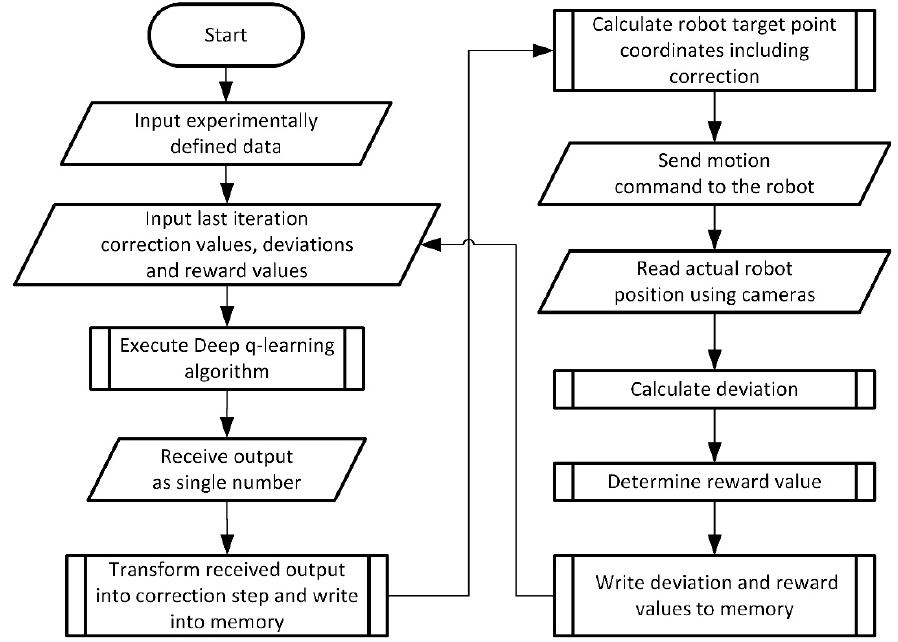
Figure 15. Flowchart of machine learning based positioning errors compensation procedure. The compensation parameters were applied by shifting the stated start and endpoint positions of the trajectory provided in Figure 3. The efficiency of the proposed methodology was evaluated by measuring positioning accuracy at the start and endpoint of the robot trajectory (Figure 16). During the experiment, the robot was loaded with a 0.5 kg payload and moved at maximum velocity.